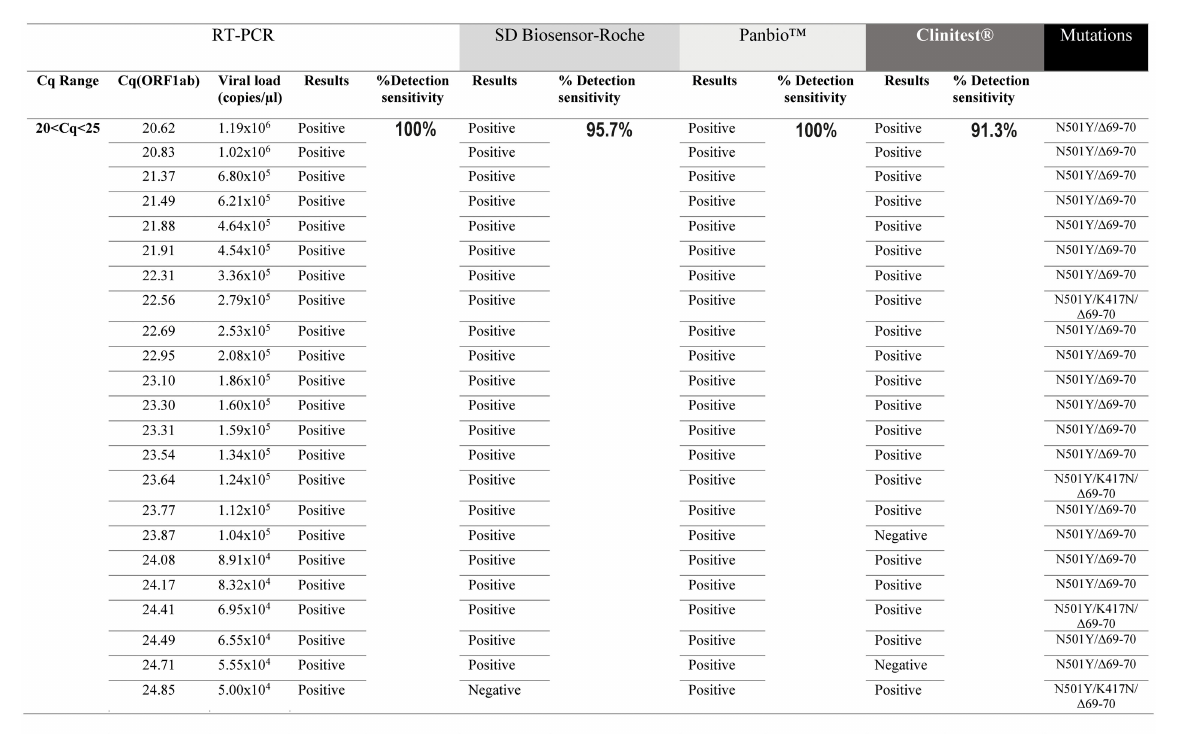
FIGURE1 Evaluation of the sensitivity for the rapid antigen test SD Biosensor-Roche, Panbio TM and Clinitest ® in detecting the Omicron variant at 20 ≤ Cq < 25 range. All samples were positive for RT-PCR (100%). A total of 23 samples were analyzed. The same NPSs were analyzed by all four methods (RT-PCR and three RATs). N501Y/ 1 69-70del and N501Y/K417N/ 1 69-70del mutations correspond to subvariants BA.1 and BA.4/5,